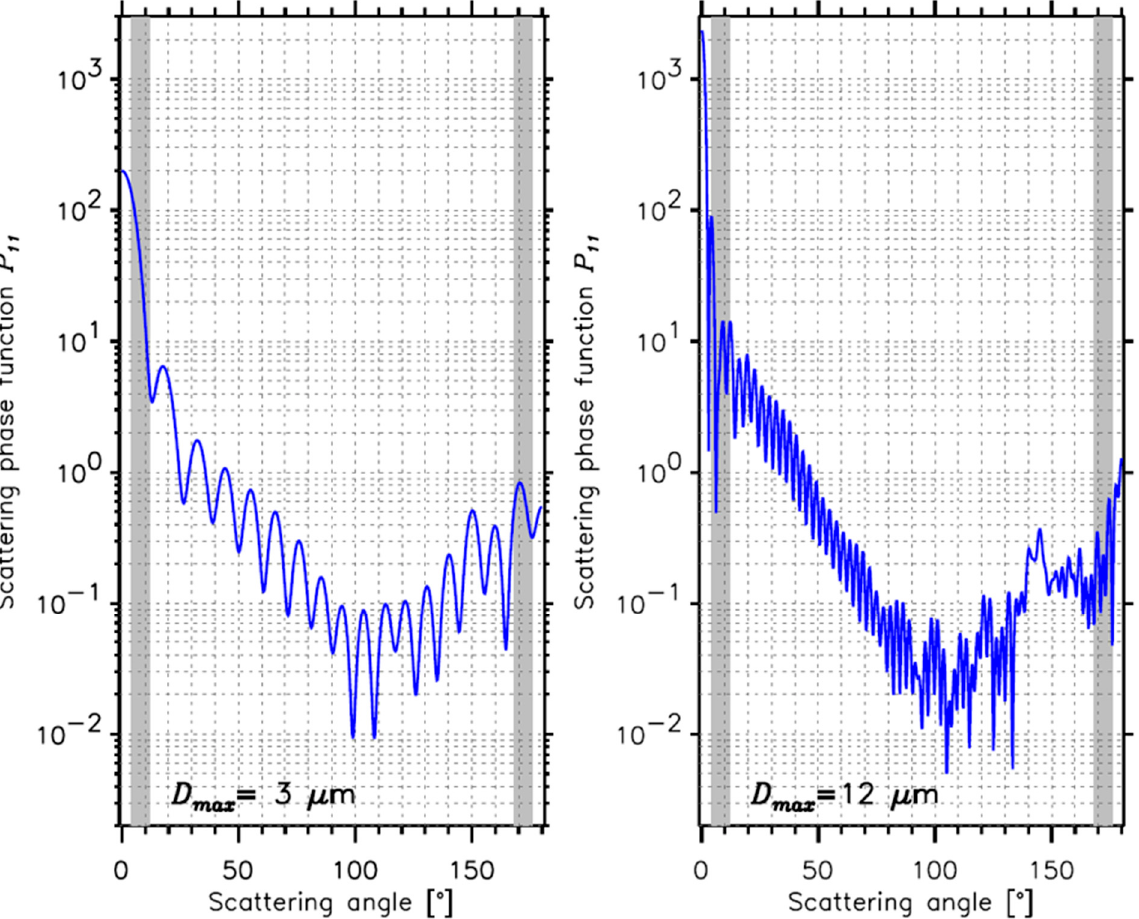
Figure 1. Calculated scattering phase function ( P 11 ) of spherical liquid cloud droplets with maximum dimensions D max = 3 μ m ( left ) and D max = 12 μ m ( right ) using a Lorenz–Mie code at a wavelength λ = 0.55 μ m. The ranges of light collection angles in forward (4°–12°) and backward (168°– 176°) directions are shaded in each panel.